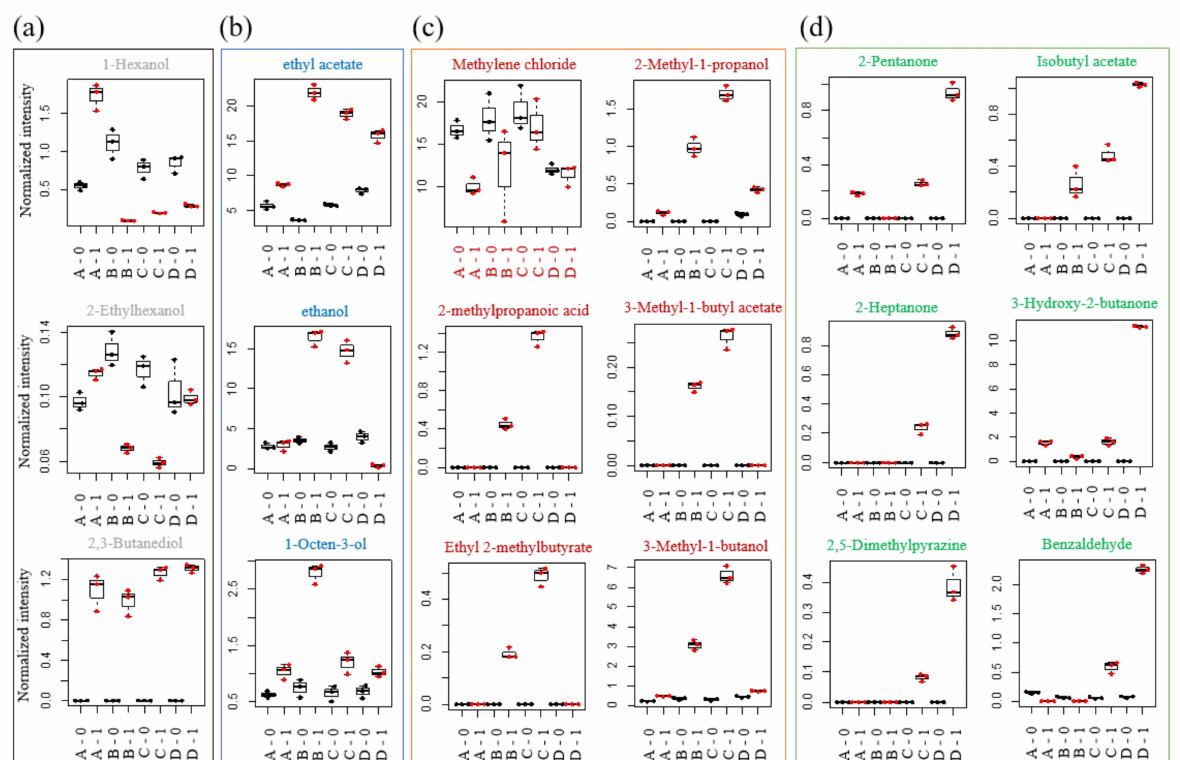
Figure 2. Boxplots derived from GC-MS data from Meju samples reveal metabolic changes during fermentation with different starters. ( a ) Volatiles increased in Group A as control without starter, ( b ) volatiles increased in Group B inoculated with A. oryzae KCTC 46471, ( c ) volatiles increased in Group C inoculated individually with B. velezensis and A. oryzae , and ( d ) volatiles increased in Group D co-inoculated with B. velezensis and A. oryzae between pre- and post-fermentation for 0–1